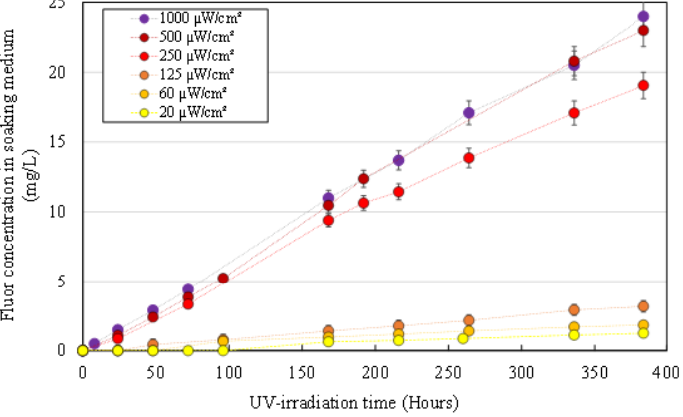
Figure 2. Fluorine concentration in UV irradiated HFs soaking medium for different irradiation powers.